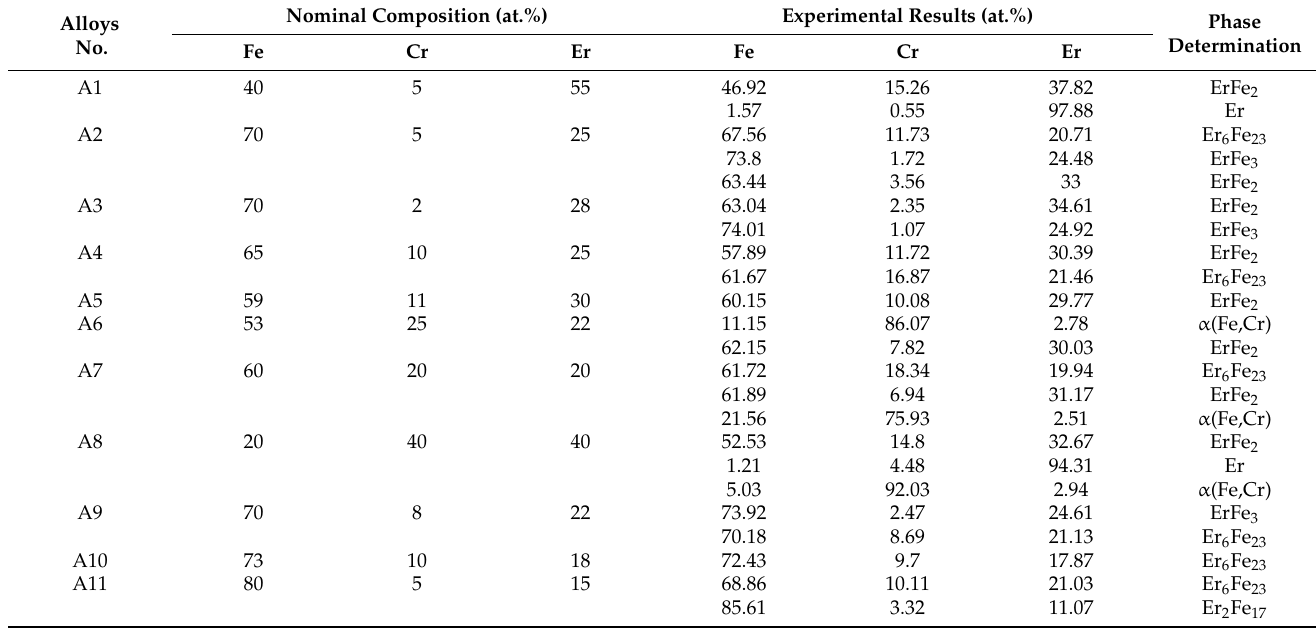
Table 2. Constituent phases and compositions in the annealed Fe–Cr–Er alloys at 1273 K for 60 days. Alloys